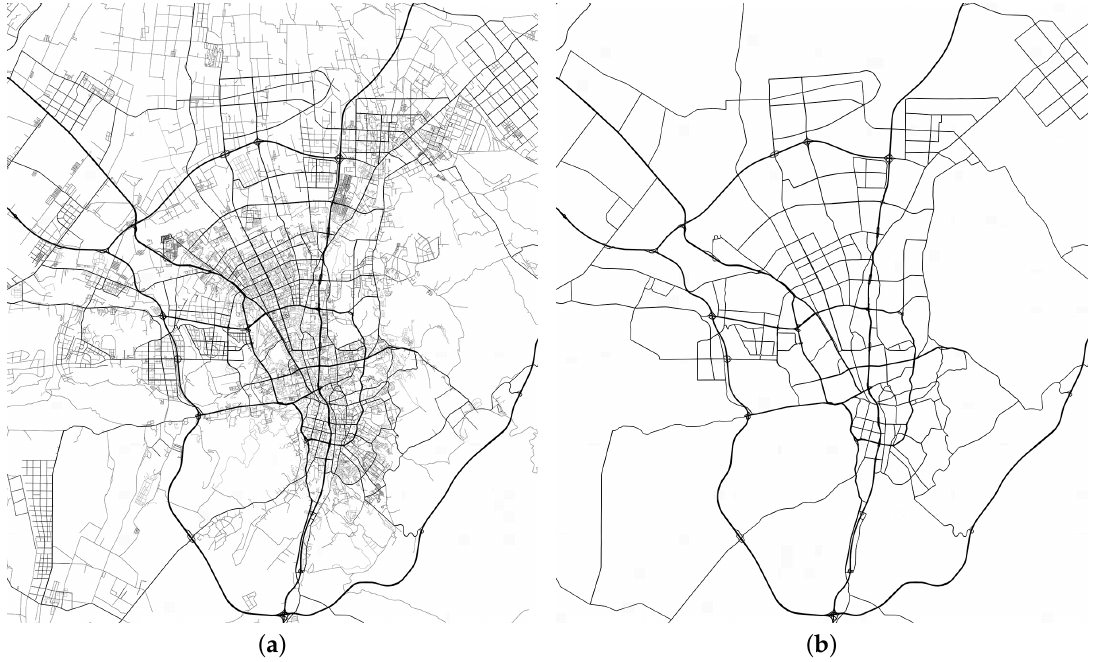
Figure 5. The road network map of Urlumqi. ( a ) L1 road network map of Urlumqi; ( b ) L2 road network map of